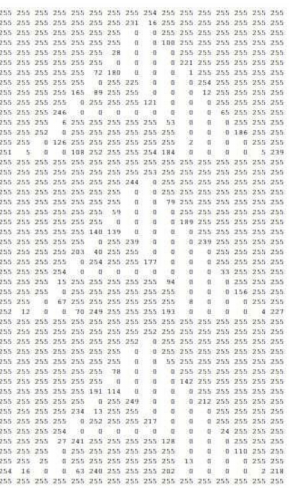
Figure 22. Extract from a.PATT file with an image